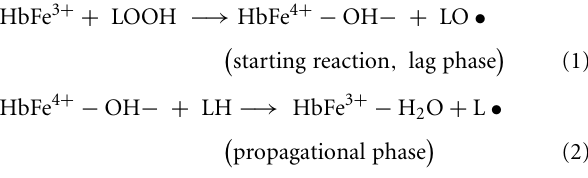
The time course of reaction at 405nm. (B) Shows spectra taken from (A) where the starting ferryl spectra have been set to zero. The rate constants for the two phases were determined by fitting the reaction time courses to a double exponential equation. (C) : HbA, (D) : HbF. The solid lines represent the double rectangular hyperbolic functions. Open symbols represent Hb α subunit, and closed symbols represent Hb β subunit (or γ subunit in